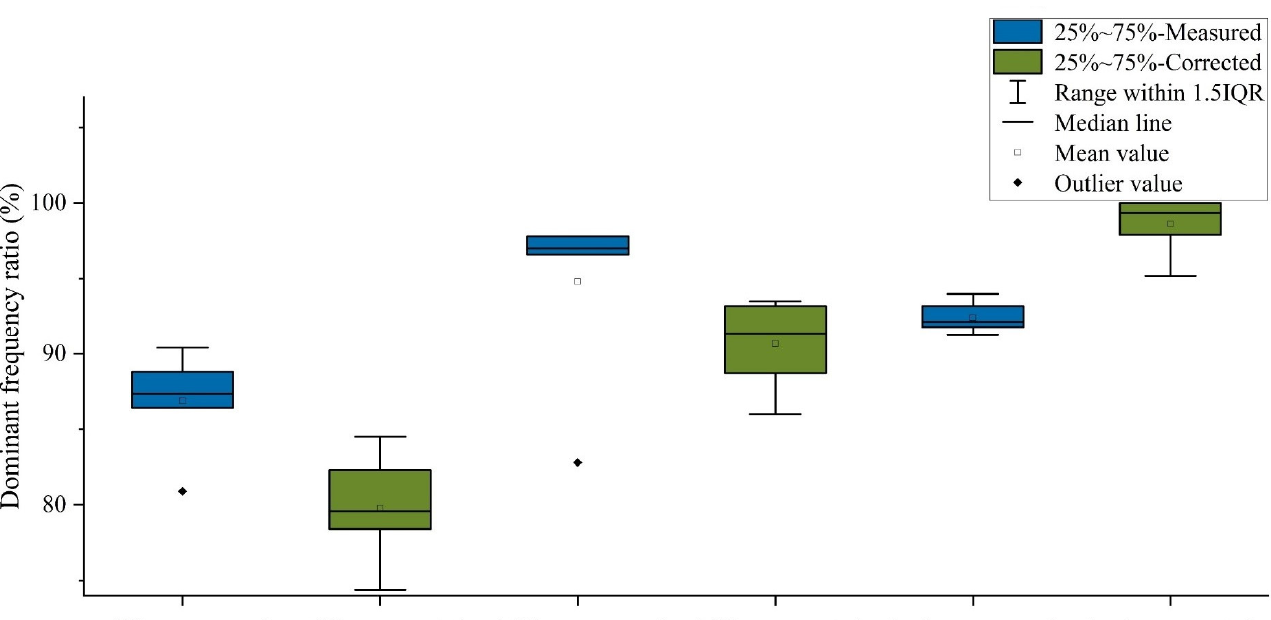
Figure 14. Box diagram of the dominant frequency of load under different processes.